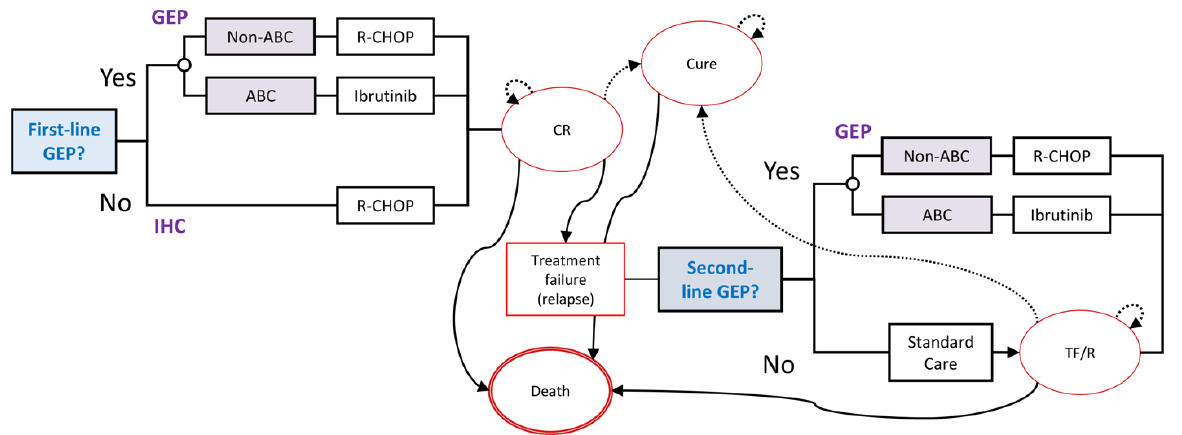
Figure 1. Decision model schematic. The Markov model simulates a hypothetical cohort of DLBCL patients over a ten-year time horizon. The Markov model health states are: complete response (CR), treatment failure or relapse (TF/R), cure or full remission, and death. The model had four health states: complete response; treatment failure/relapse; full remission; and a terminal death state. The cohort begins in the complete response state